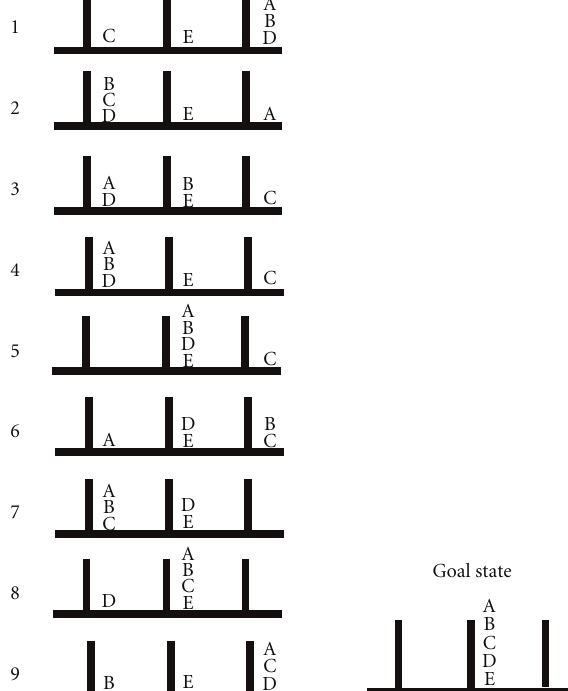
Figure 1: ( Adopted from Goel and Grafman, 1995). Start states for 9 of the 10 ToH trials used in the study. The tenth trial (not included in the diagram) had a start state in which discs A to E were all placed on the right peg, and it was administered after the 9th trial.